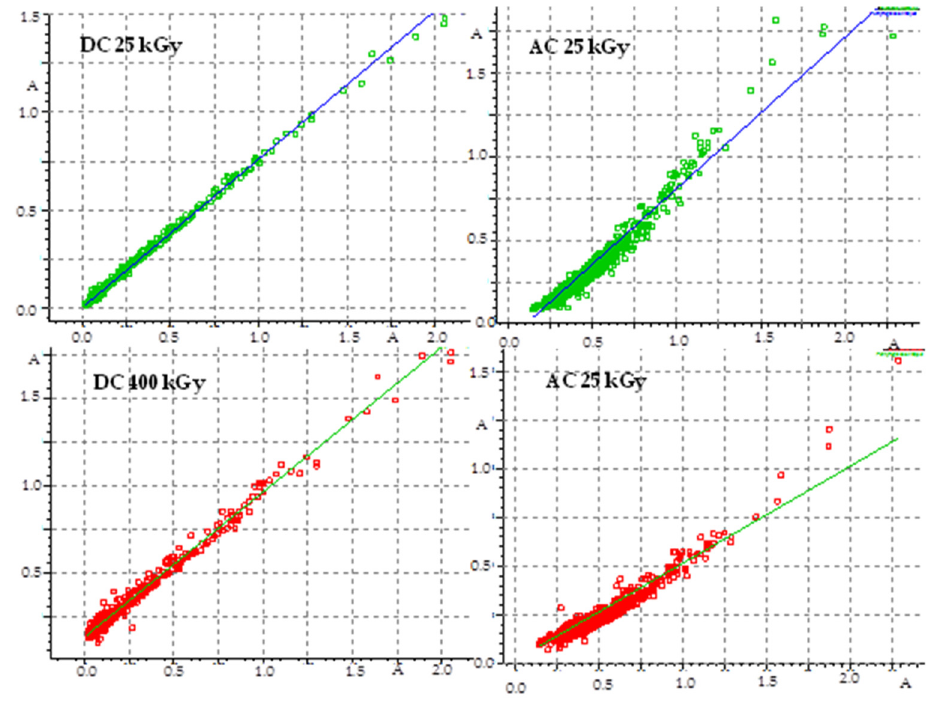
Figure 7. Graph of FT-IR spectra compatibility before and after irradiation.